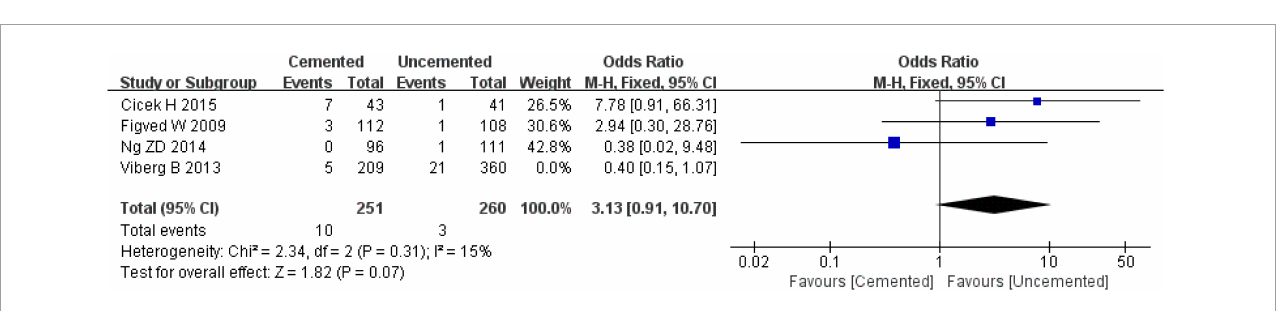
FIGURE9 Forest plot for comparison of revision rate between cemented bipolar hemiarthroplasty (CBH) group and uncemented bipolar hemiarthroplasty (UCBH)